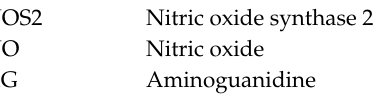
Figure S1: IL-6 and IL-8 levels in the culture medium of HaCaT scratched monolayers treated with the soluble fraction from probiotic